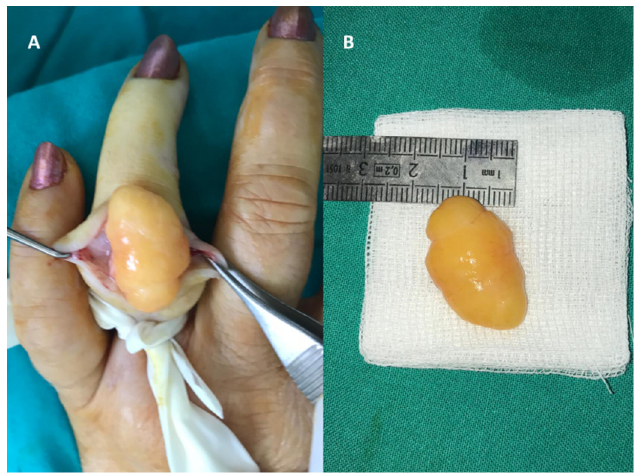
Figure 5. Intraoperative aspects of lipoma excision: ( A ) wrist, ( B ) thenar eminence, and ( C ) dorsal face of the index finger with removed specimen ( D ).